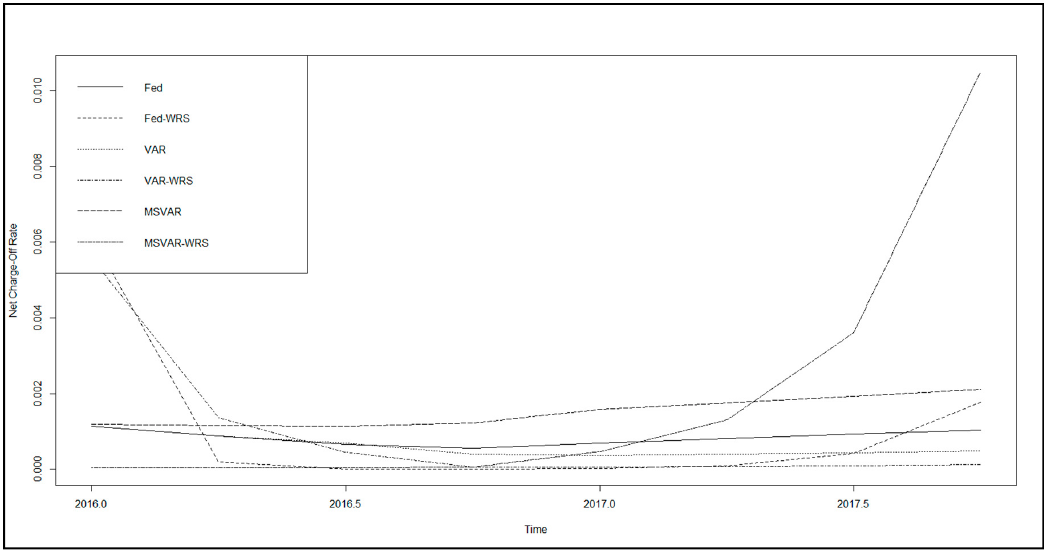
Figure 10. Kullback–Leibler relative entropy worst-case loss for model risk quantification plot—unemployment rate, CBOE equity volatility index, BBB corporate—five-year treasury bond spread, and total uncommitted loan growth (FDIC SDI Report, Federal Reserve Board 4Q91–4Q15 and Jacobs (2018) models).